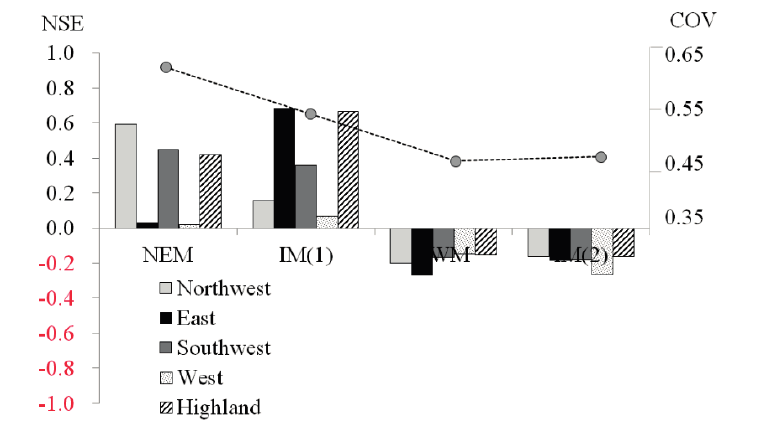
Figure 11. Average seasonal NSE of the TRMM 3B43 against ground rainfall in local climate regions and average rainfall from areal rainfall surfaces for the period